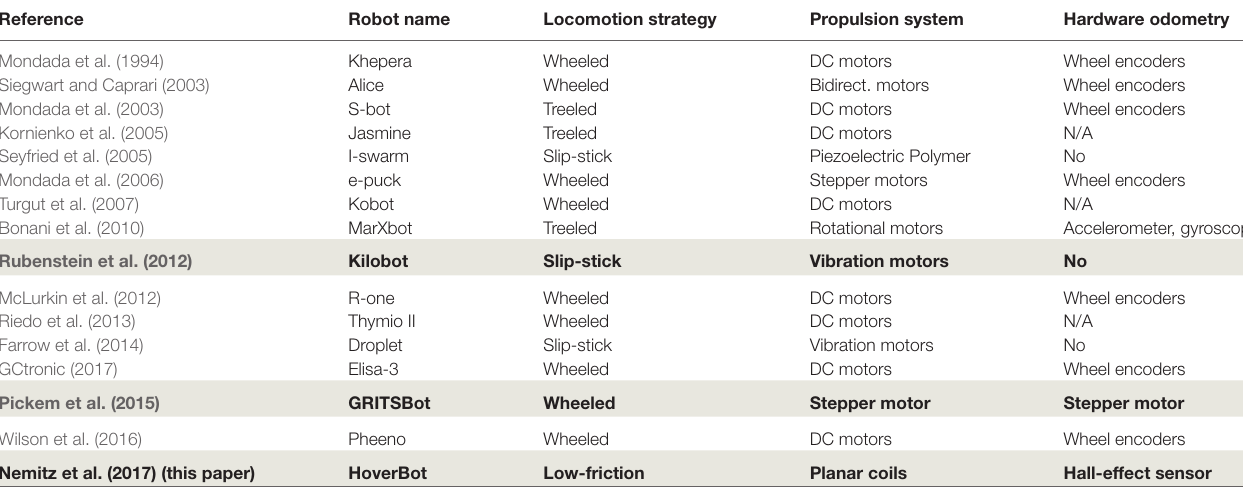
TaBle 1 | Comparison of 16 swarm robotic systems found in the